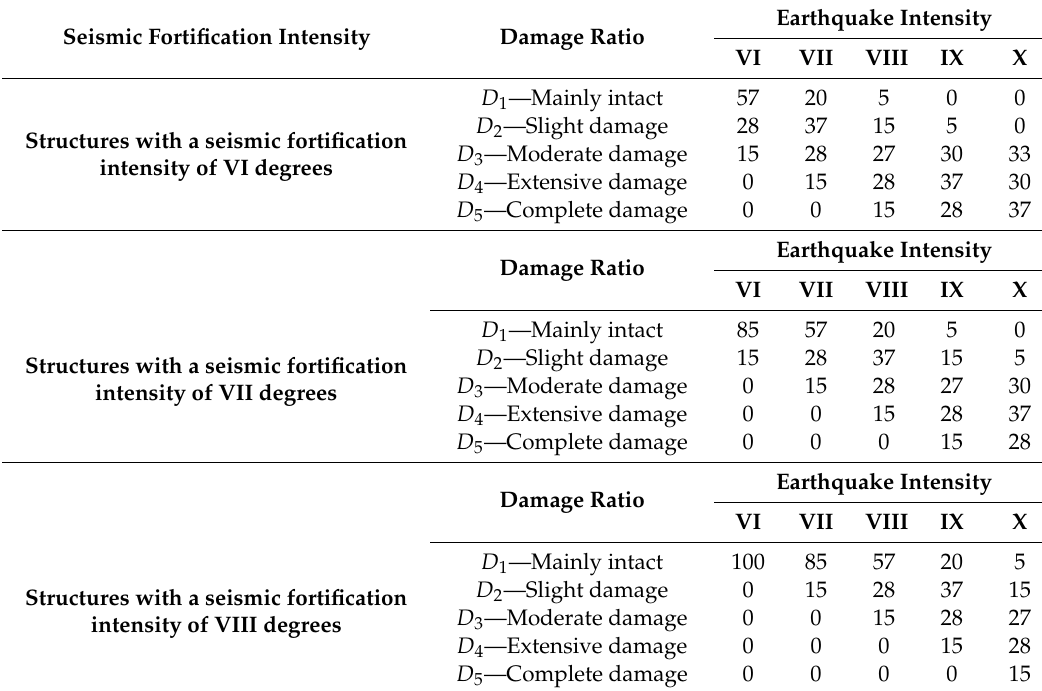
Table3. Thevaluesofdamageratiosfordi ff erentstructurefortificationswithdiverseseismicfortification intensities facing di ff erent earthquake intensities (unit: